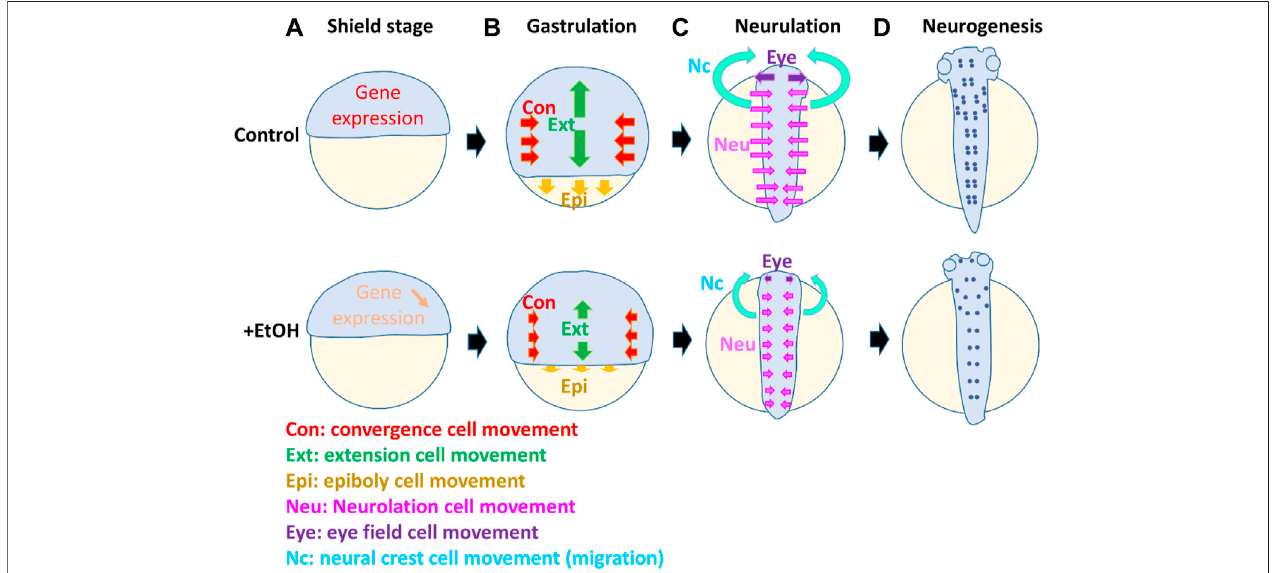
FIGURE 1 | Model suggesting multiple targets of ethanol which affect cell differentiation, cell movement, and morphogenesis during different stages in the early embryo development. The diagram shows zebra fi sh embryos in normal development and compromised development in the presence of ethanol. At the onset of the gastrula stage [shield stage, (A) ], the gene expressions (e.g., sox2 crucial for stem cells and CNS development) are suppressed by ethanol (downward arrow). During gastrulation (B) ,ethanolaffectsthecellmovementofconvergence(Con,redarrows),extension(Ext,greenarrows),andepiboly(Epi,yellowarrows).Smallerarrows in the ethanol-exposed embryo indicate the reduced distance of these cell movements. Subsequently, during neurulation (C) , ethanol affects the neurulation cell movement (Neu, pink arrows), by which the fl at neural plate cells move to the midline and form a neutral tube. Reduced distance of the neurulation cell movement (pink arrows)causesincompleteclosureofthebrainandspinalcord.Attheneurulationstages,cellmovement alsooccursintheeye fi eldand neuralcrest.Thesingleeye fi eld (Eye) moves to the left and right, separating and forming two eyes. Neural crest cells which are derived from the side of the neural plate migrate anteriorly and form craniofacial structures. These eye fi eld and neural crest cell movement (purple and light blue arrows, respectively) are also suppressed by alcohol, causing reduction of the distance of two eyes and craniofacial malformation. At the neurogenesis stage (D) , the number of neurons (purple dots) is reduced by ethanol, and axon growth is